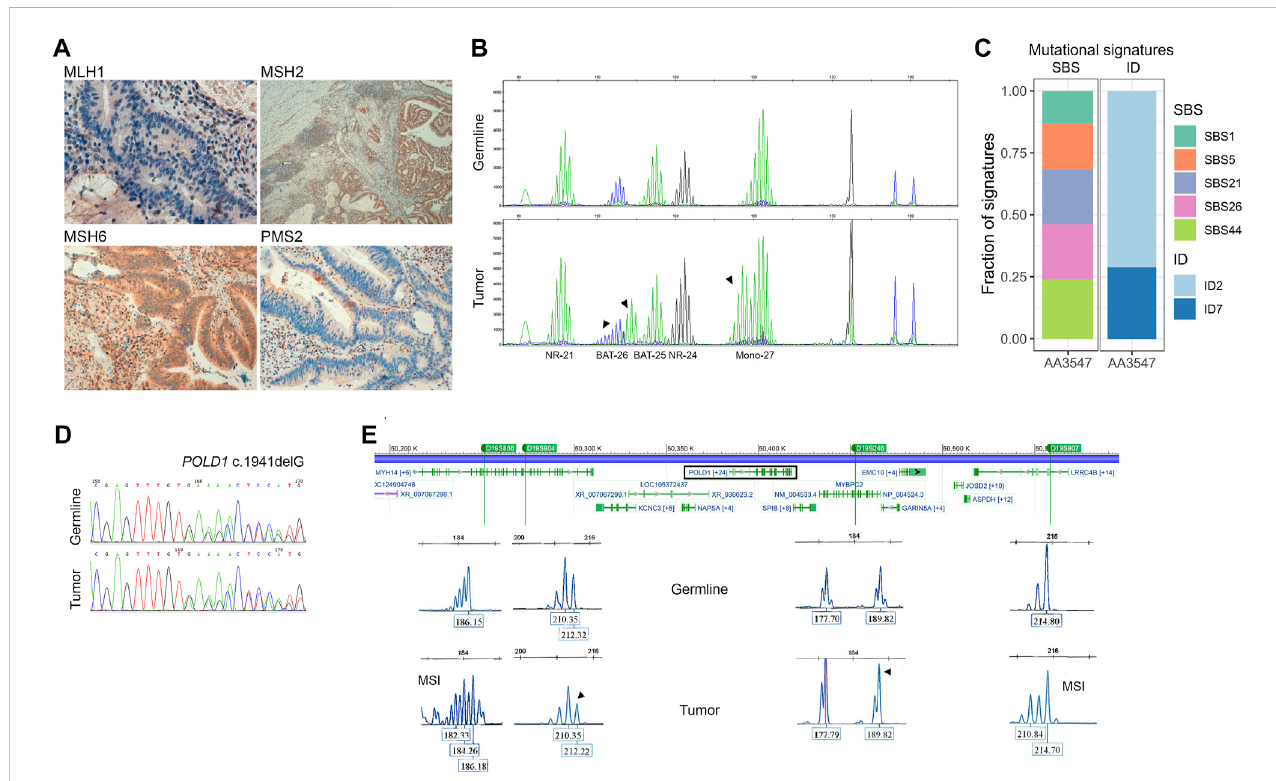
FIGURE 2 Somatic characterization of the index case. (A) Immunohistochemistry for MMR proteins showing loss of MLH1 and PMS2 expression. (B) Microsatellite instability analysis in germline DNA (upper panel) and tumor DNA (lower panel). All markers showing instability are marked with an arrow. (C) Contribution of single base substitution(SBS) andsmall insertionsand deletions (ID) mutationalsignatures ona tumoral DNA sample from theproband (AA3547). (D) Loss-of- heterozygosity assessment by Sanger sequencing and by (E) PCR-ampli fi cation of four microsatellite markers close to POLD1 (rectangle). The four loci D19S866, D19S904, D19S246 and D19S907 are depicted in green. LOH is indicated by an arrow. MSI, microsatellite